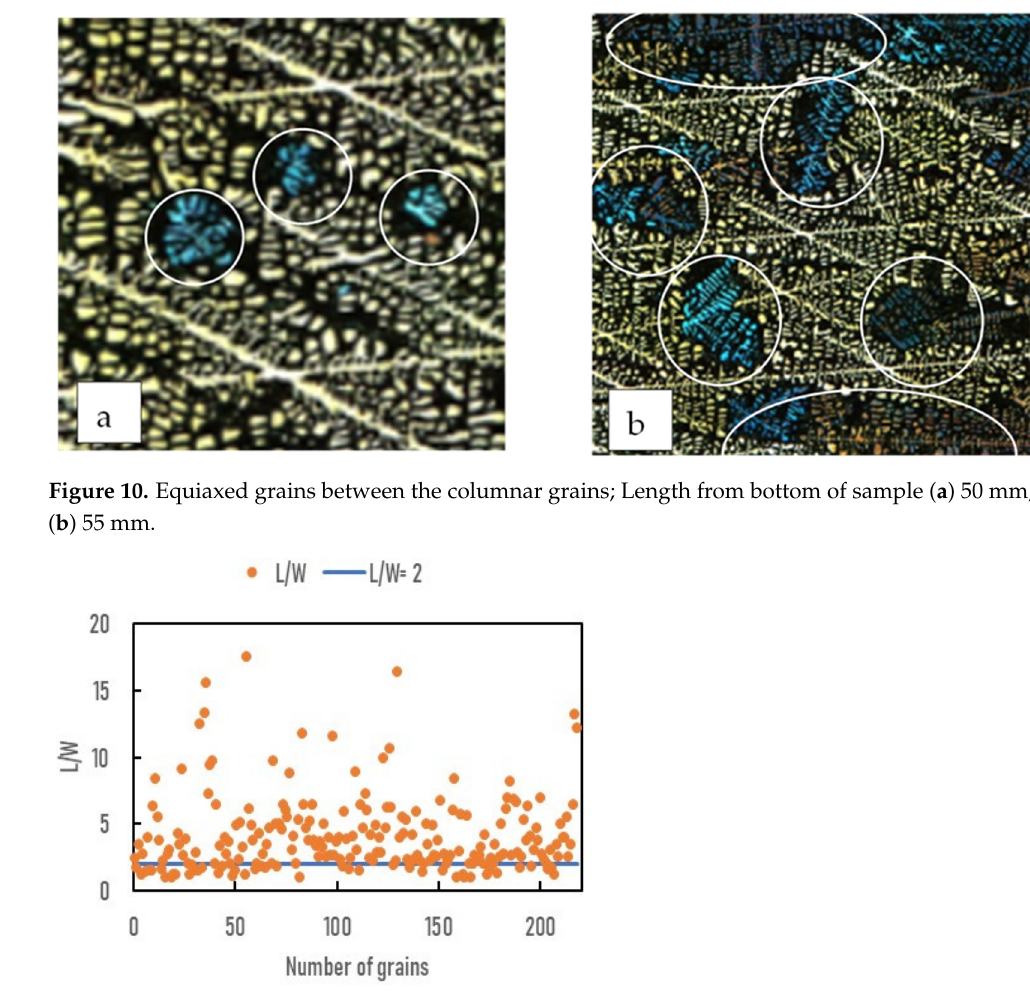
Figure 11. Length/width of the 250 grains between the cross Sections 6 and 7 in the sample GB1.